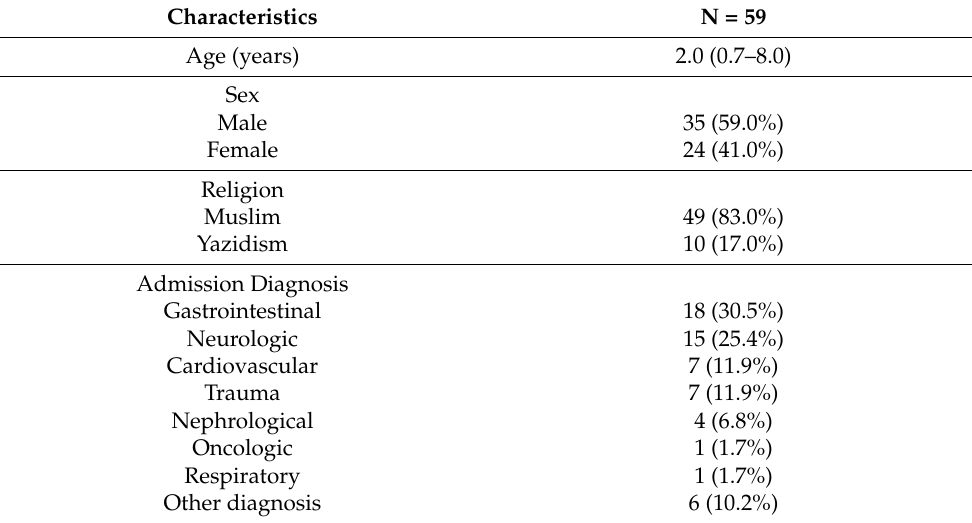
Table 1. Demographic and clinical characteristics of the patients.